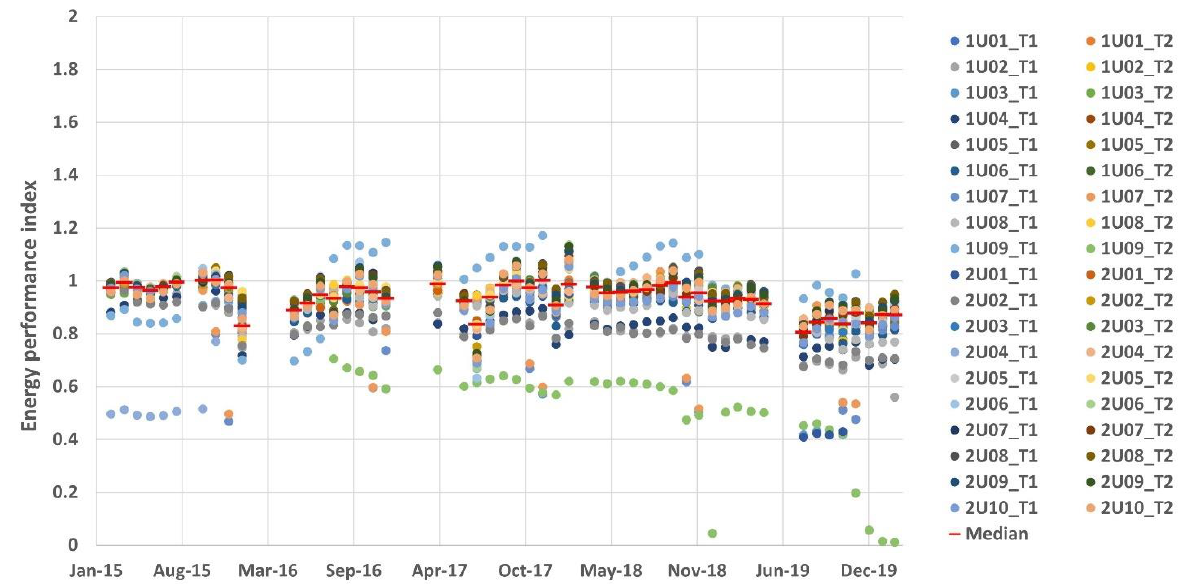
Figure 10. EPI − string (MPPTs) comparison (statistical model).